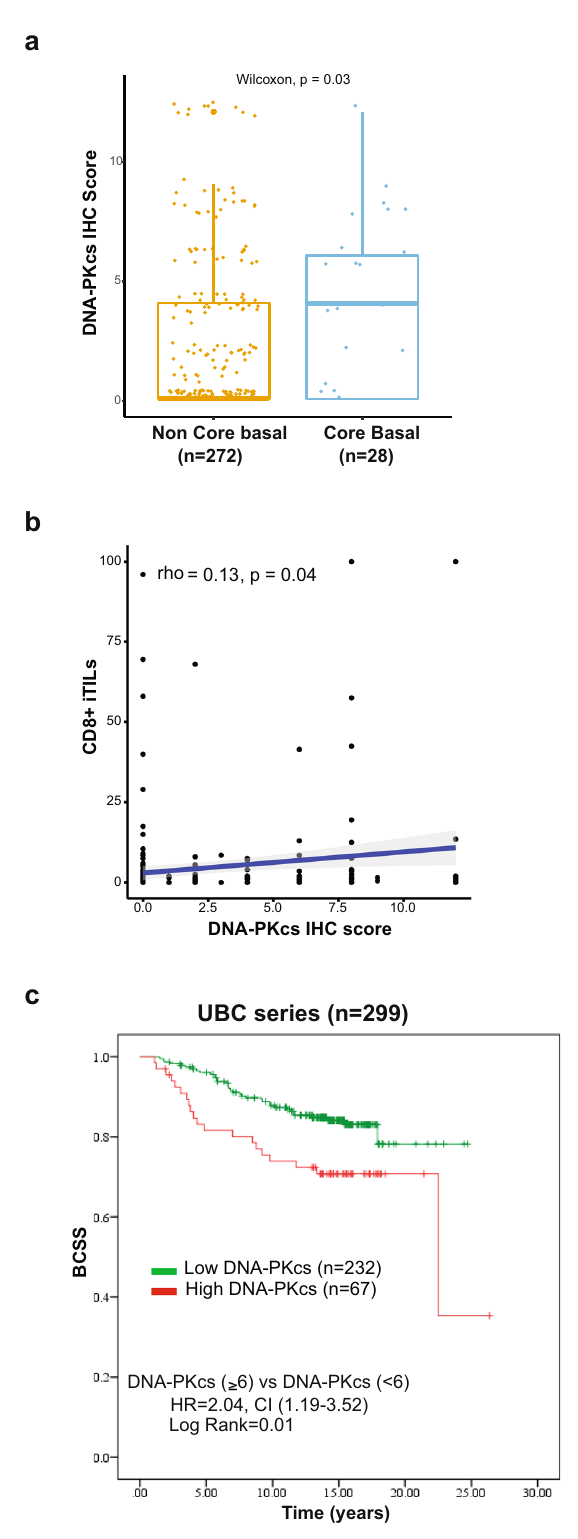
PAM50 subtype using data obtained from a contemporary collection of primary breast cancer tissues from women enrolled in the SCAN-B trial 40 (NCT02306096) (Fig. 6d). High PRKDC was signi fi cantly associated with poor disease-free survival rates in the TCGA cohort (Fig. 6e) and when applying KMplotter to 35 publicly